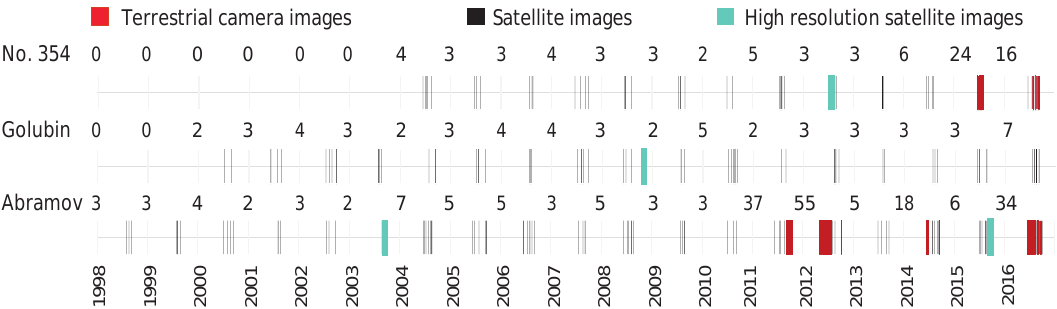
Figure 3. Image availability and distribution for snow line mapping. Numbers indicate the total available scenes per year and glacier. Prior to 1998, image coverage is sparse for all three glaciers. For Golubin and Glacier no. 354, the first summer seasons for which enough TSL observations could be collected were in 2000 and 2004, respectively. Snow-covered high-resolution images have not been used to delineate the snow line and are not shown